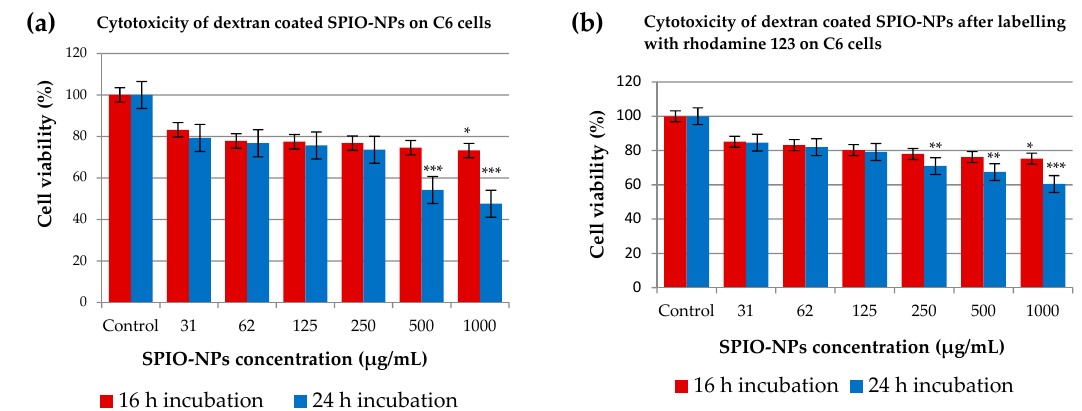
Figure 3. The effects of dextran 70,000-SPIO-NPs ( a ), and dextran 70,000-SPIO-NPs labelled with rhodamine 123 ( b ) on the viability of C6 glioma cells, determined by MTT assay. Statistical analysis revealed that 16 h incubation with 1000 µg/mL dextran 70,000-coated SPIO-NPs significantly reduced the cell viability as compared to control (* p < 0.05). In the case of 24 h of NPs incubation, 500 and 1000 µg/mL induced the cell viability significantly (each *** p < 0.001). For the rhodamine 123-labelled dextran 70,000-coated SPIO-NPs, results were similar: cell viability was only significantly reduced at a NPs concentration of 1000 µg/mL when incubation time was 16 h (* p < 0.05). However, when NPs remained for 24 h in the cell culture, 1000, 500, and 250 µg/mL concentrations induced a significantly reduced cell viability, as compared to control (** p < 0.01; *** p < 0.001). For each group, 5 wells per plate were treated identically, and each experiment was performed with at least 3 plates.